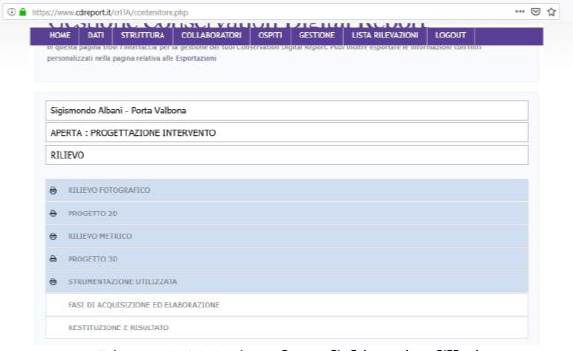
Figure 4. CDR interface: fields to be filled